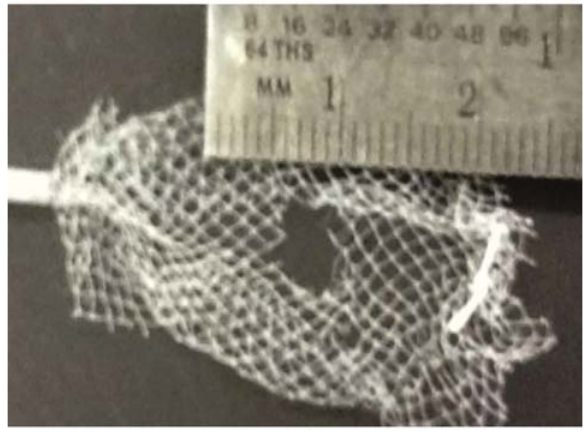
Figure 2 - UroNet Retriever with 4 mm mesh defect after